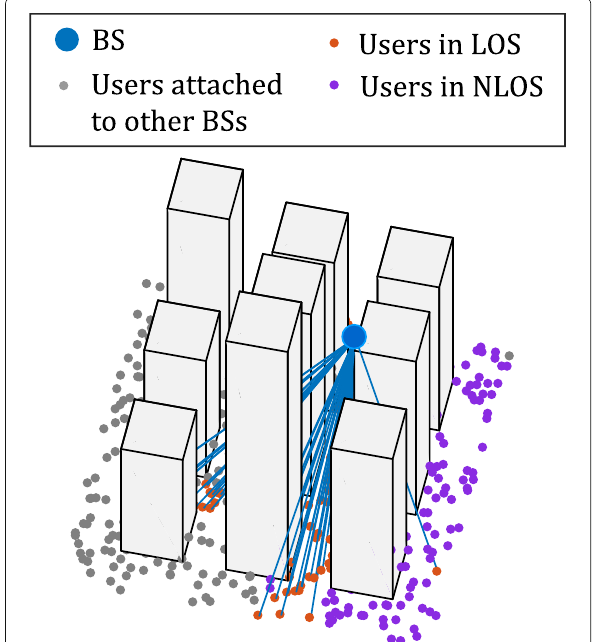
Fig. 8 Deterministic LOS link decision in a Manhattan grid scenario. This figure shows an example of deterministic LOS link condition in 3D where the BS is placed on top of a building. The connection lines denote the users in LOS associated to the BS